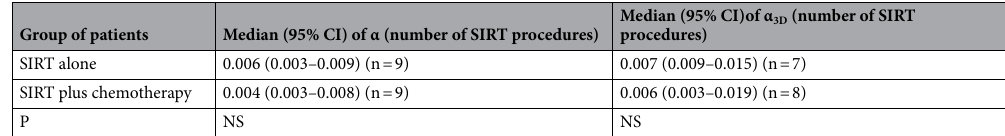
Table 4. Comparison between patients submitted to SIRT alone and SIRT plus chemotherapy in terms of α and α 3D values. No statistically significant differences were found between two groups. NS not